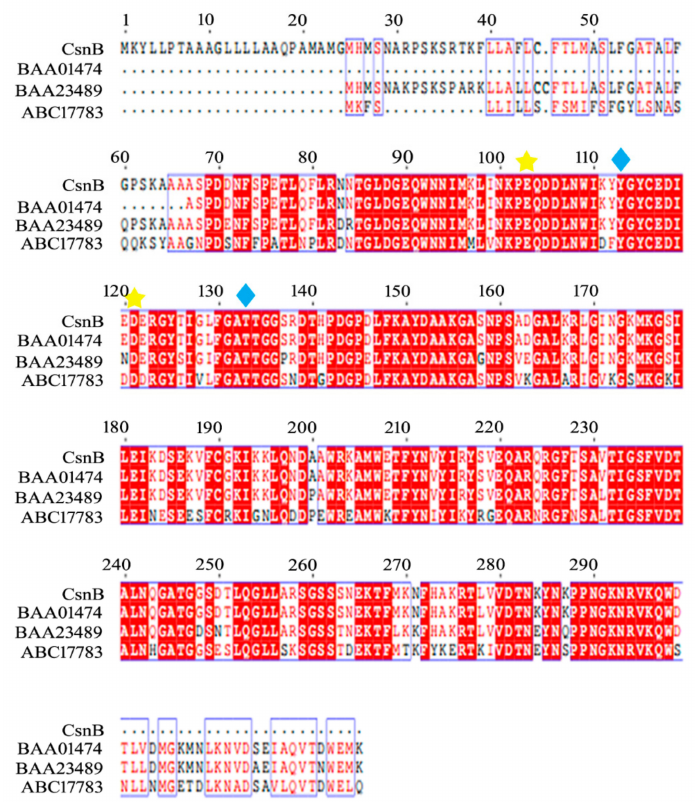
Figure 2. Sequence comparison of CsnB with related chitosanases from GH family 46. Chitosanase MH-Kl (Genbank number: BAA01474); chitosanase from Paenibacillus ehimensis (Genbank number: BAA23489) and chitosanase from Paenibacillus sp. BH-2005 (Genbank number: ABC17783). The identical substrate binding and catalytic sites were marked with blue rhombus and yellow stars,